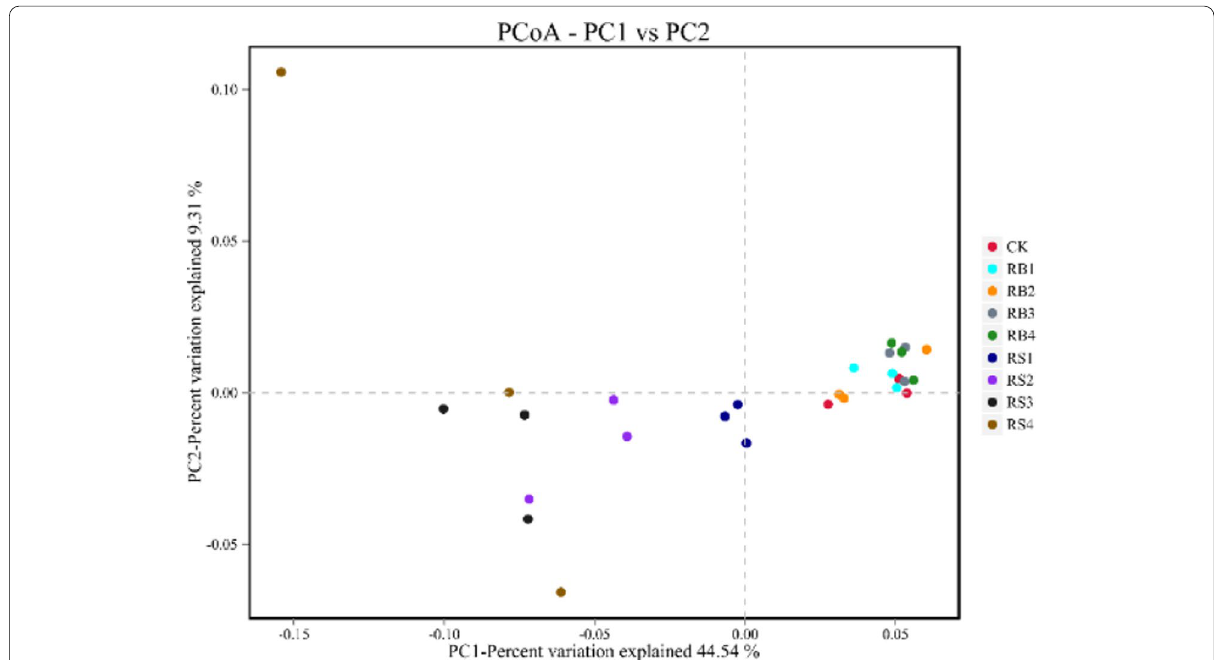
Fig. 3 Principal coordinate analysis of different treatments